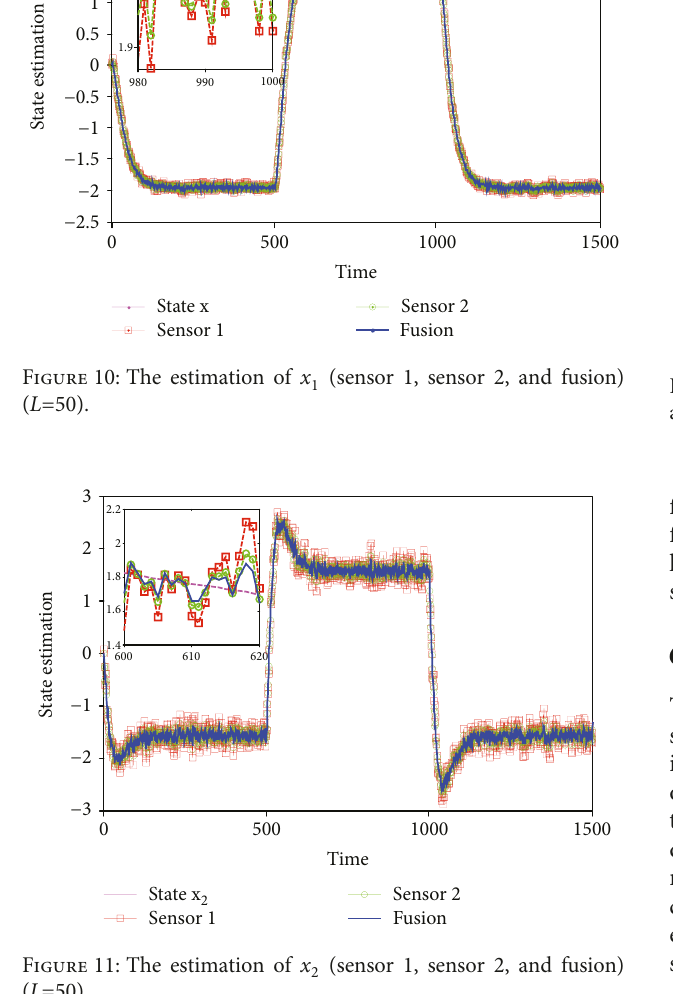
2 (sensor 1, sensor 2, and fusion)